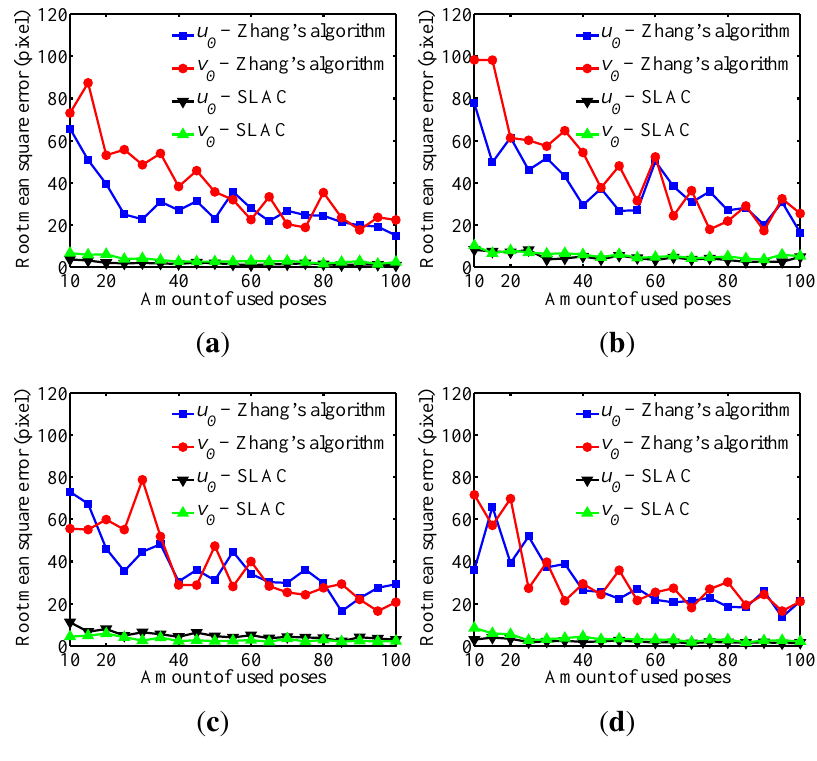
Figure 12. Simulation results for the u poses. ( a ) Camera 1; ( b ) Camera 2; ( c ) Camera 3; ( d ) Camera